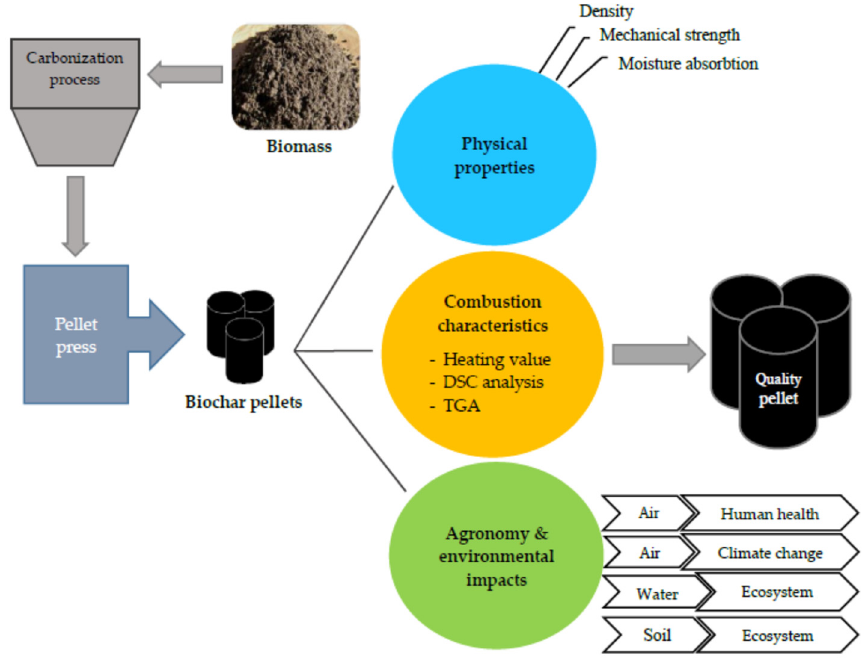
Figure 1. A process flow diagram showing the carbonization, pelletization, and characterization to produce quality biochar pellet from biomass (TGA: thermogravimetric analysis, DSC: differential scanning calorimetry).